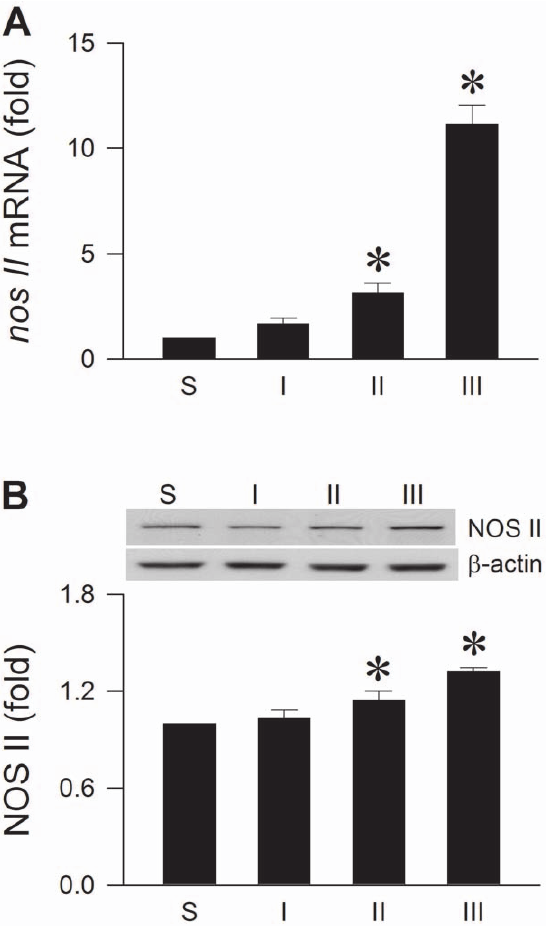
Figure 2. Drastic difference between upregulation of NOS II mRNA and protein in RVLM. Illustrative gels or summary of fold changes against sham-controls in nos II mRNA determined by real-time PCR (A) or NOS II protein detected by Western blot analysis (B) in ventrolateral medulla of rats that received IV administration of LPS (15 mg kg 2 1 ). Values are mean 6 SEM of triplicate (mRNA) or duplicate (protein) analyses on individual samples obtained from 5–6 animals per experimental group. * P , 0.05 versus sham-control group in the Scheffe´ multiple-range test.